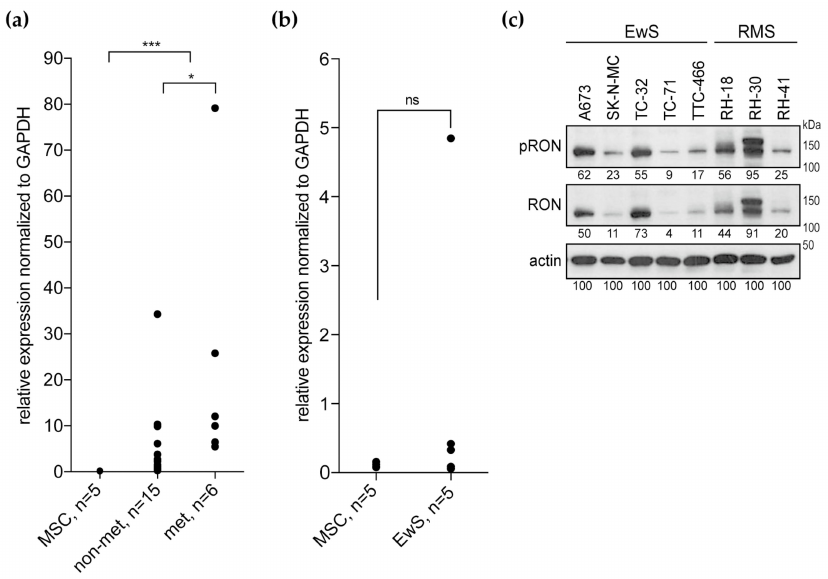
Figure 1. RON is expressed in Ewing sarcomas and cell lines. ( a ) Relative RON transcript expression in Ewing sarcoma primary tumors from patients with localized (non-met) or metastatic (met) disease in comparison to MSC cultures, as determined by qPCR. ( b ) Respective RON expression in Ewing sarcoma cell lines (EwS) compared to MSC cultures. ( c ) RON protein is expressed and phosphorylated in Ewing sarcoma and rhabdomyosarcoma (RMS) cell lines. Cells were grown in standard tissue culture conditions. Following analysis of phospho-RON, blots were stripped and re-probed for total RON expression; 10% gel; numbers indicate densitometry readings relative to respective actin loading